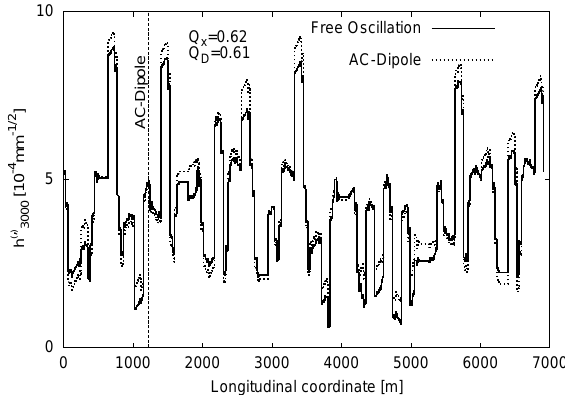
FIG. 4. Comparison between the theoretical amplitudes of the Hamiltonian terms h 0 3000 (with ac dipole) and h 3000 (free oscilla- tion) plotted versus the longitudinal